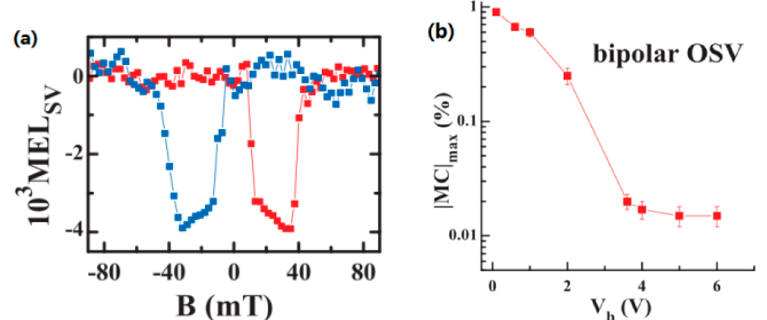
Figure 10. ( a ) A MEL loop after subtraction of the background in a typical spin-OLED device with organic layer thickness of 25 nm measured at V b = 4.5 V and T = 10 K. The red (blue) loop stands for increasing (decreasing) external magnetic field. The switches of the MEL correspond to the coercive field of the FM electrodes. ( b ) The normalized maximum magneto-conductivity in bipolar devices as a function of bias voltage. Adapted from [35], with permission from © 2012 The American Association for the Advancement of Science.